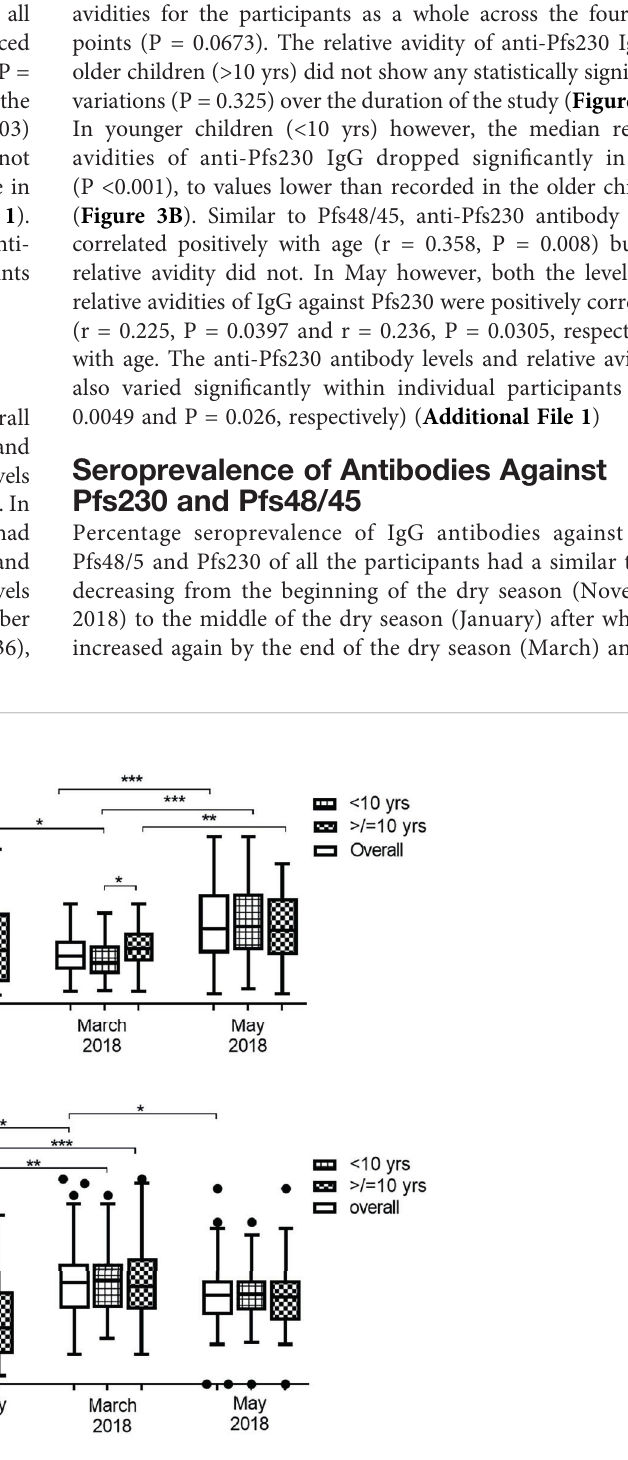
FIGURE 2 | Changes in Pfs48/45 IgG level (A) and avidity (B) in 43 children <10 years and 41 children ≥ 10 years over the dry season spanning November 2017 to May 2018. Yrs, years. The extent of statistically signi fi cant difference in measurements indicated by *, ** and *** represent P <0.05, P <0.01, and P <0.001